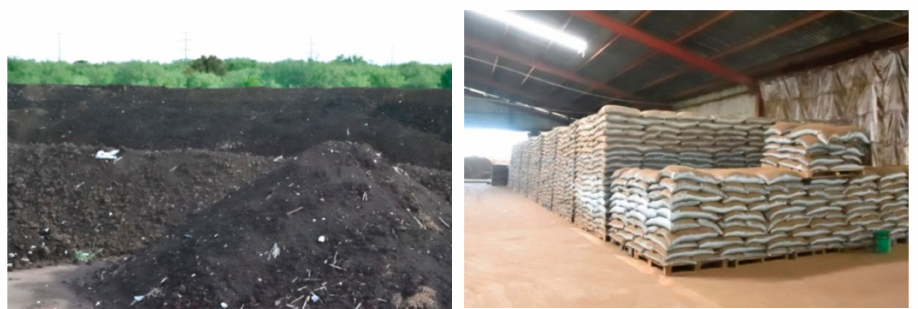
Figure 1. Poultry manure processing and storage.